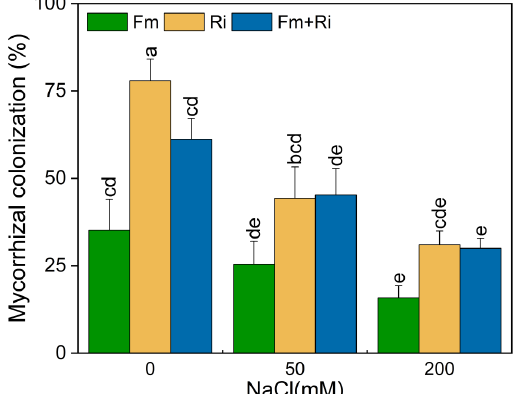
Figure 1. Mycorrhizal colonization in the root systems of Cinnamomum camphora plants under 0, 50 and 200 mM NaCl. Fm, Ri, and Fm+Ri represent the three mycorrhizal treatments: inoculation with sterilized mycorrhizal fungi, with Funneliformis mosseae or Rhizophagus irregularis, either alone or in combination, respectively. Values are presented as the mean ± SE ( n = 3). Different lowercase letters indicate a significant difference according to LSD at p < 0.05.